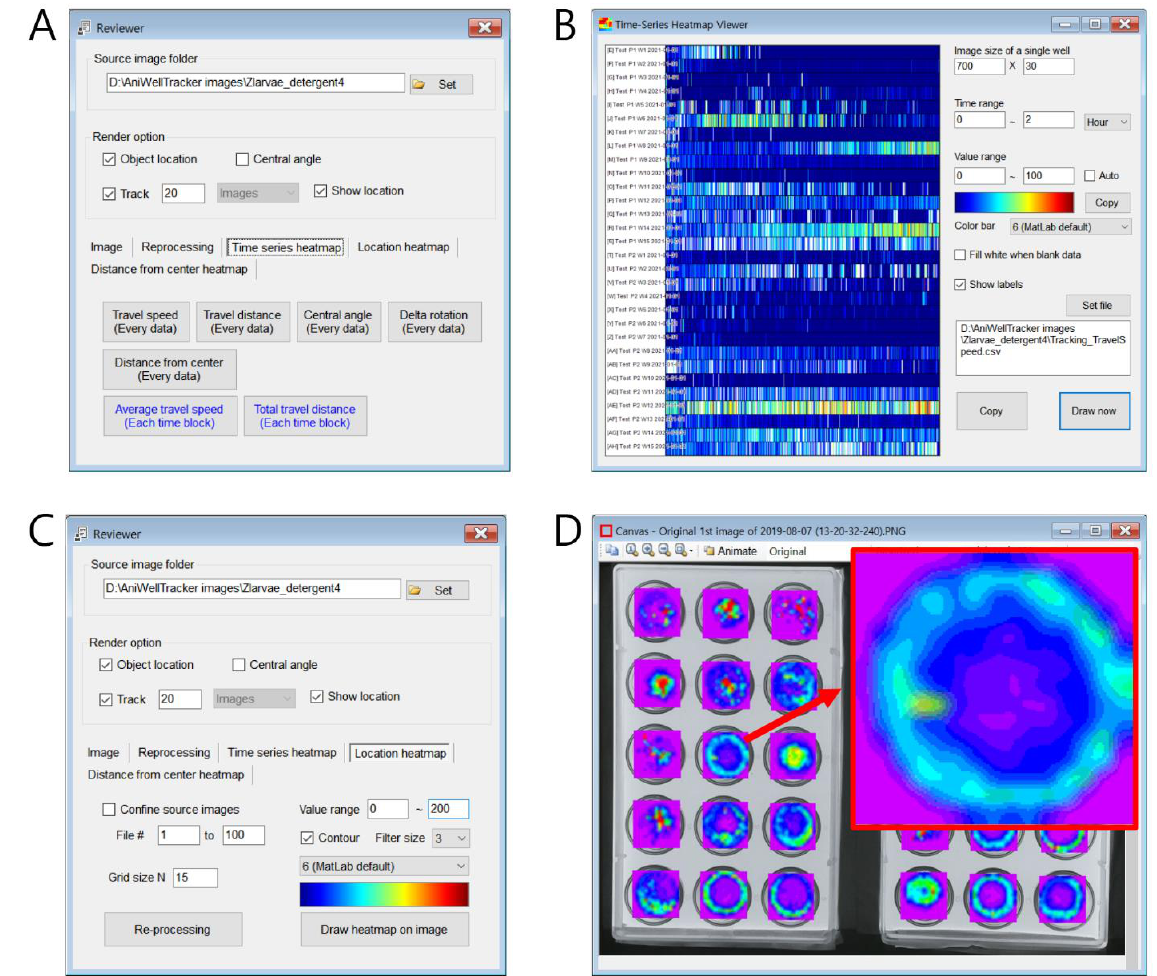
Figure 4. Post-data processing and visualization in the Reviewer window. ( A ) In the Time series heatmap tab, various analysis endpoints can be drawn as a time series heatmap chart. ( B ) Time-Series Heatmap Viewer window reads a CSV format file and draws a chart. ( C ) In the Location heatmap tab, the location frequency of the centroid of the animal can be drawn as a heatmap chart. ( D ) The location heatmap is overlapped on the original image of the Canvas window.